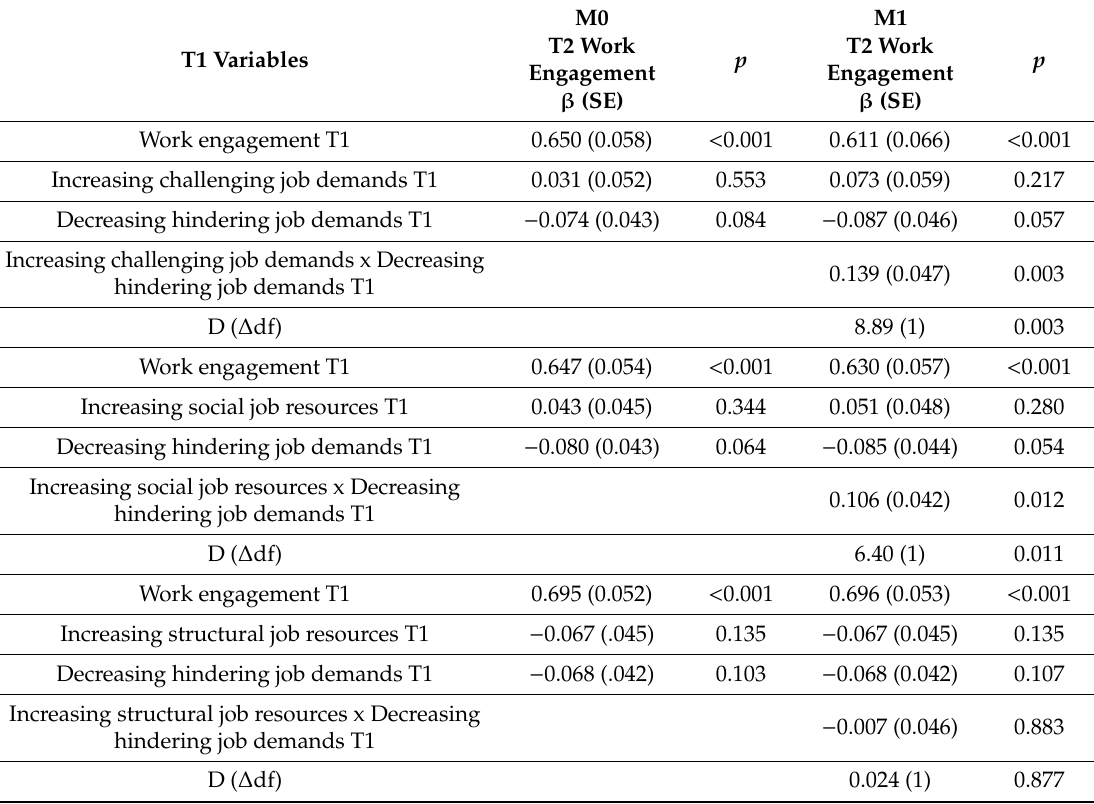
Table 3. Results of LMS: interaction e ff ects of job crafting dimensions on work engagement among participants facing changes in their work content ( n =